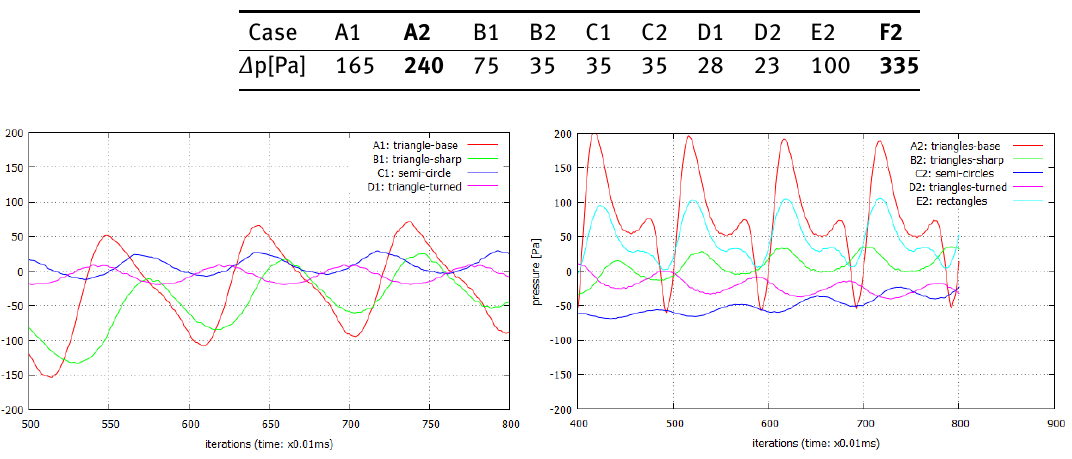
Figure 6: Pressure evolution at the center S of the diaphragm for the cases A1, B1, C1, D1 containing one bluff body (left) and for the cases A2, B2, C2, D2, E2 containing two bluff bodies